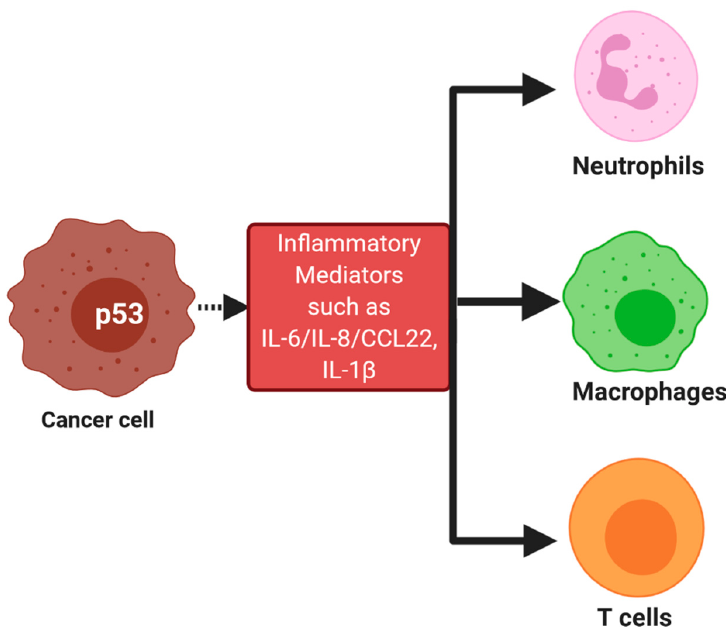
Figure 1. Infiltration of immune cells due to activation of p53: The activation of p53 in cancer cells can be due to many factors such as TLR5-flagellin interaction. Due to this activation of p53, the inflammatory mediators are released, which leads to the infiltration of immune cells in the tumor microenvironment. These immune cells include neutrophils, macrophages, and T cells.